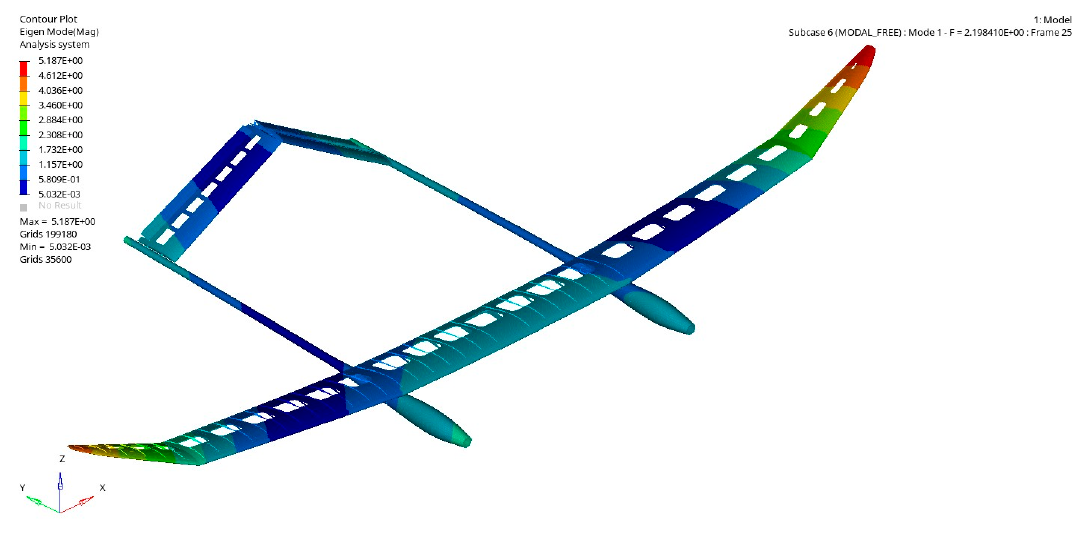
Figure 16. The first calculated natural frequency.